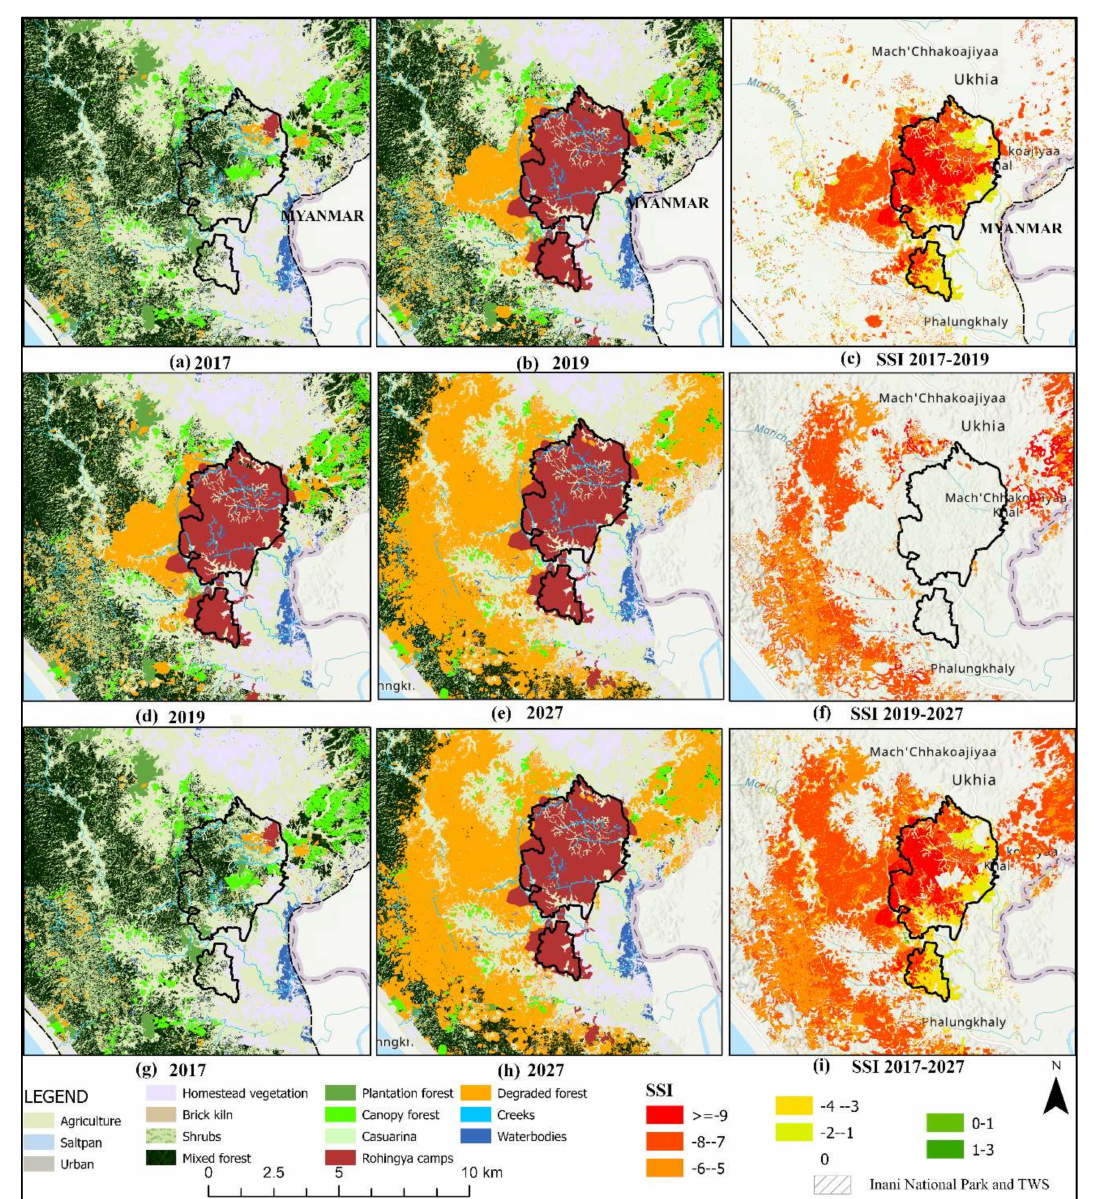
Figure 6. Spatial severity of impact of anthropogenic stresses (Rohingya influx) on the forest ecosystem. The figure is a close-up demonstration of the process of SSI to assess the severity of the impact on the study area after the Rohingya